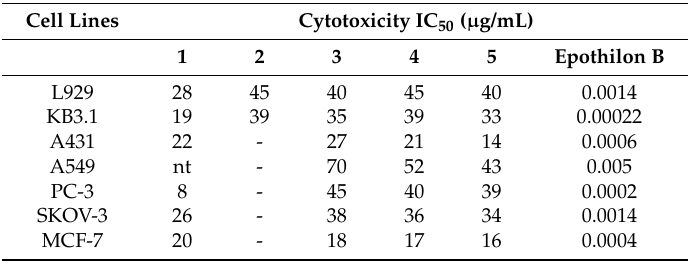
Table 3. Cytotoxic activities of compounds 1 – 5